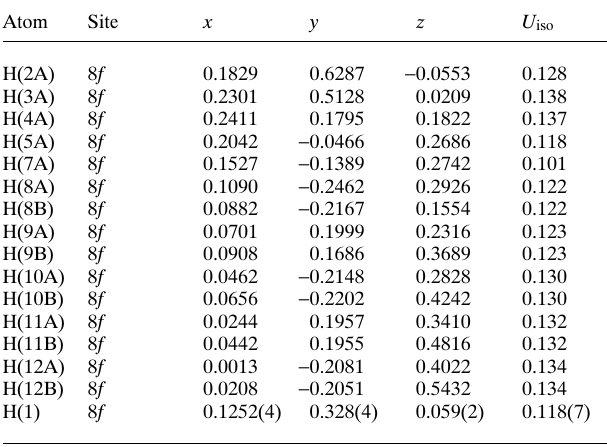
Table 2. A tomic coordin a tes a nd displ a cement p a r a meters (in Å 2 )